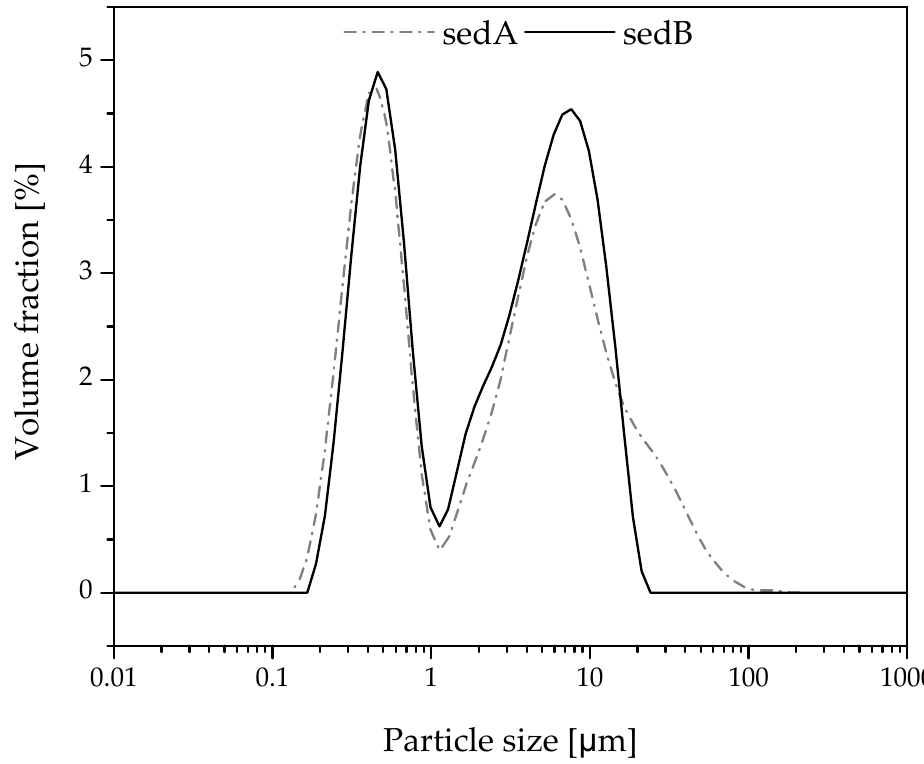
Figure 3. Distribution of particle sizes of fractionated sediments.